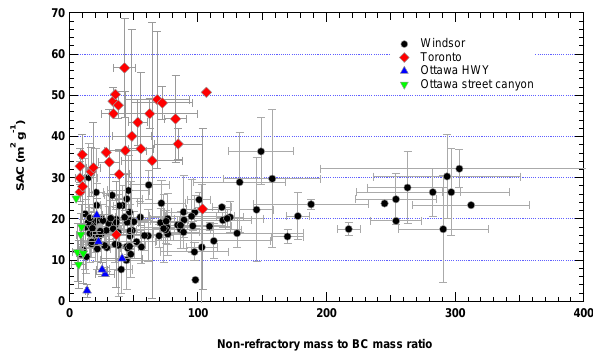
Figure 7: Relationship between the SAC and the non-refractory mass to BC mass ratio for all measurements from this study. Each data point represents an average value of a 30-minute time interval. The error bars represent the standard deviation among all the measurements in the 30-minute interval. The Windsor, Toronto, Ottawa highway, and Ottawa street canyon data are represented by black circles, red diamonds, blue upward triangles and green downward triangles, respectively.